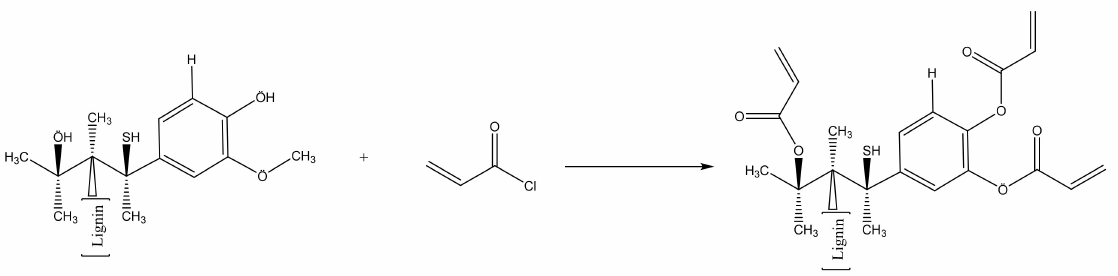
Scheme 1. Reaction for acryloyl chloride in the presence of